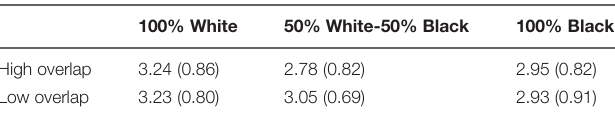
TABLE 2 | Study 3